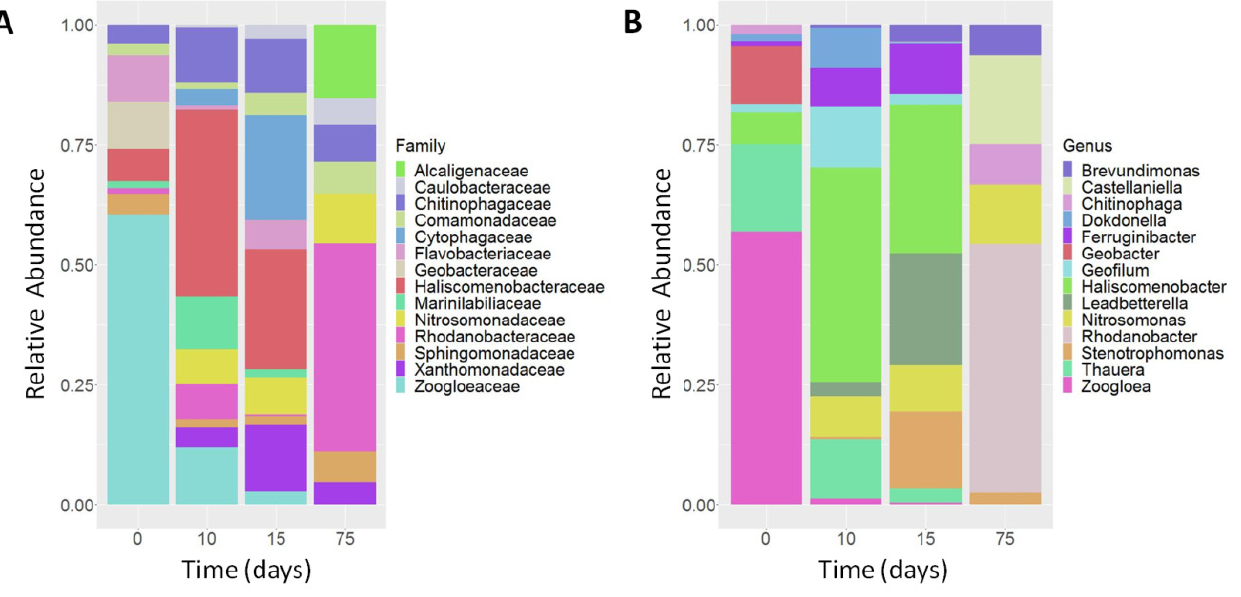
Figure 6. A 100% stacked bar-chart. Changes in the microbial composition, at family ( A ) and at genus ( B ) level of four times during the period of 75 days of RRIA (Figure 4A), as determined by sequencing of 16S rRNA.